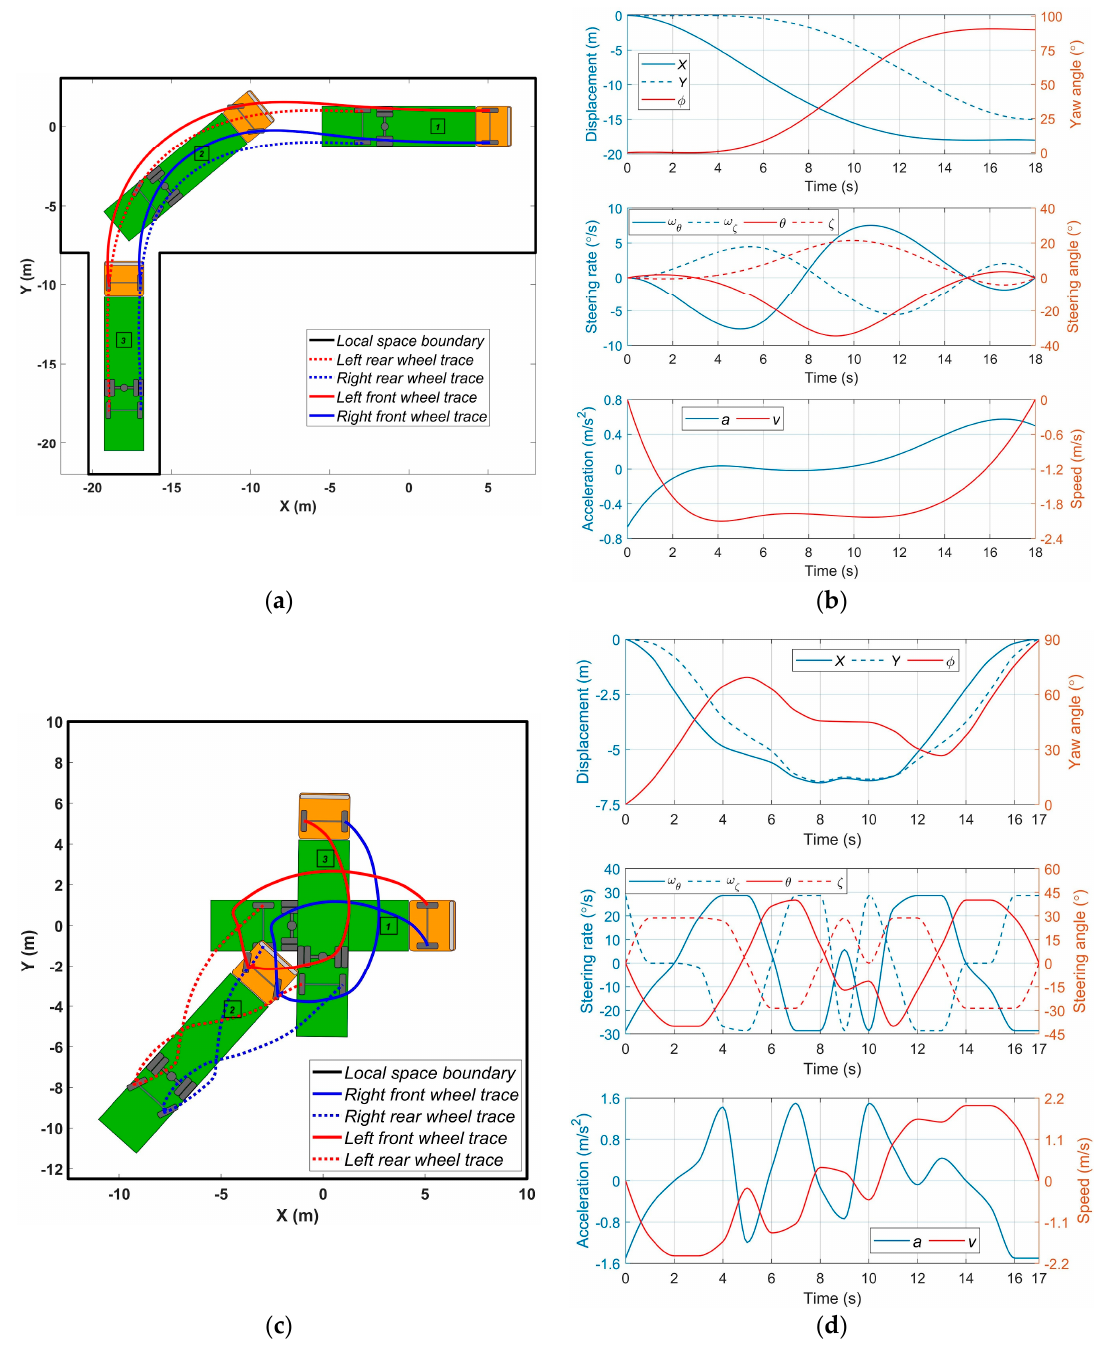
Figure 5. Single truck automated maneuvering simulation in a parking area with restricted space: ( a ) Vehicle positions and planned trajectories for perpendicular reverse parking; ( b ) Basic output and control parameters for perpendicular reverse parking; ( c ) Vehicle positions and planned trajectories for changing position on the spot; ( d ) Basic output and control parameters for changing position on the spot.